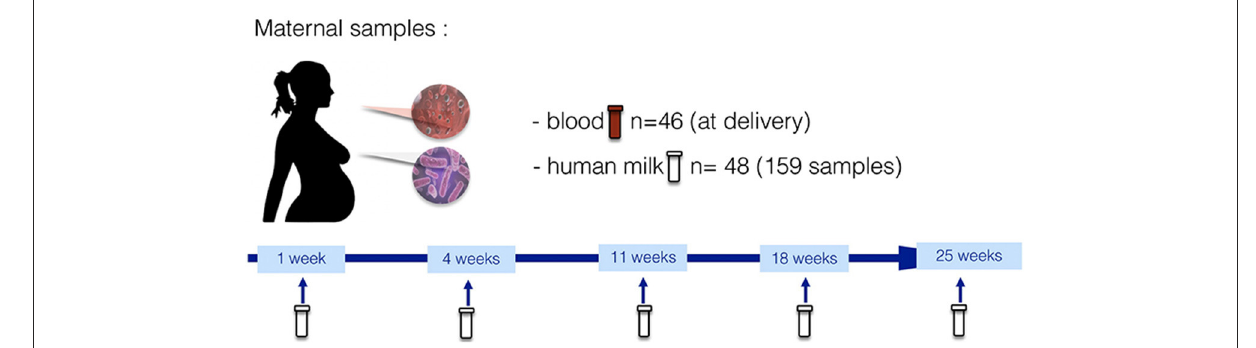
FIGURE1 Maternal biological sampling and data collection timeline in the MITICA